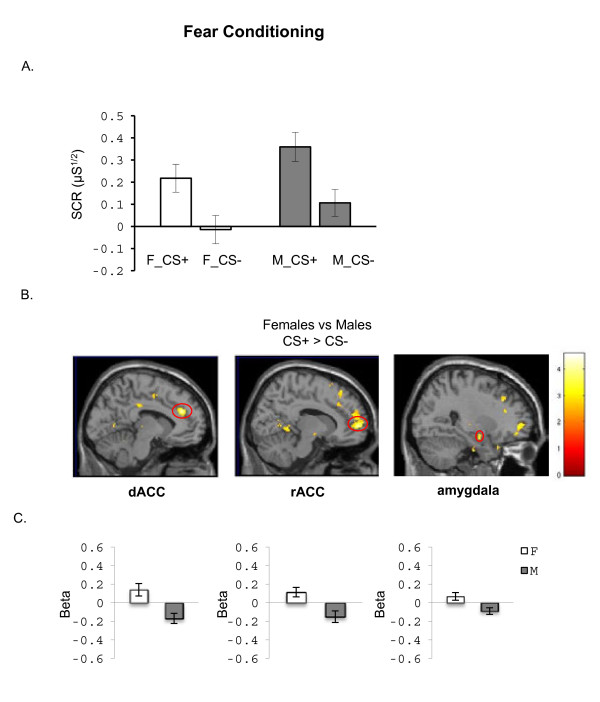
Differences between men and women in psychophysiological and BOLD measures during fear acquisition. A. Skin conductance responses (SCR) averaged across the first 4 conditioning trials for the conditioned stimulus that was reinforced, i.e. paired with the shock (CS+) and for the conditioned stimulus not paired with the shock (CS-). B. BOLD activation to the CS + vs. CS- contrasting Females vs. Males during fear conditioning is shown. C. Mean beta weights extracted from the dorsal anterior cingulate cortex (dACC), rostral anterior cingulate (rACC), and amygdala are shown, to illustrate the direction of activation within group. The threshold display for the maps in B is p < 0.01, uncorrected. M = males; F = females.